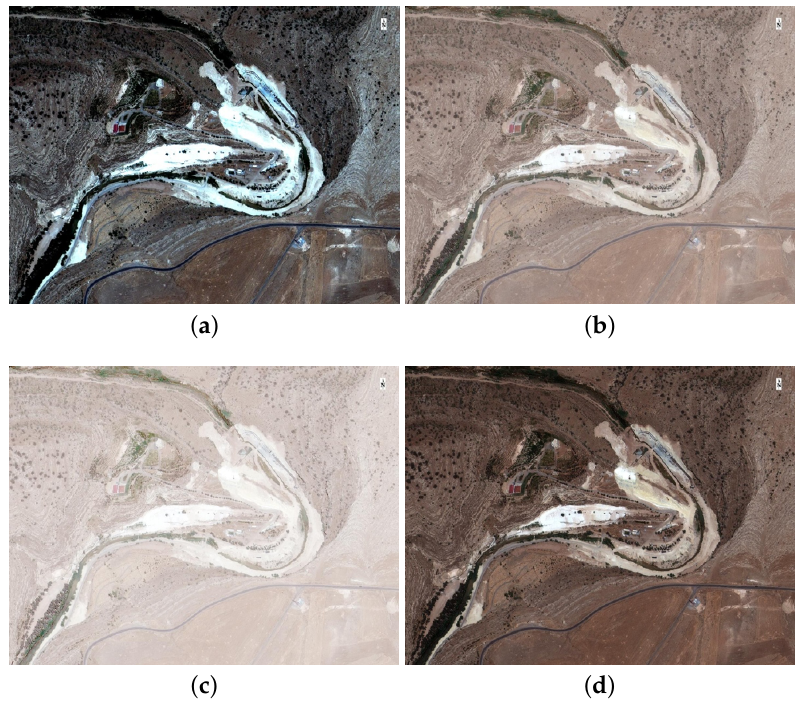
Figure 6. A comparison of the different test performed to achieve a more comprehensible result. The detail shows the area of the quarry that is overexposed and not suitable for a visual interpretation of the area. ( a ) the original picture; ( b , c ) pansharpened with failure filtering; ( d ) optimized pansharpened.